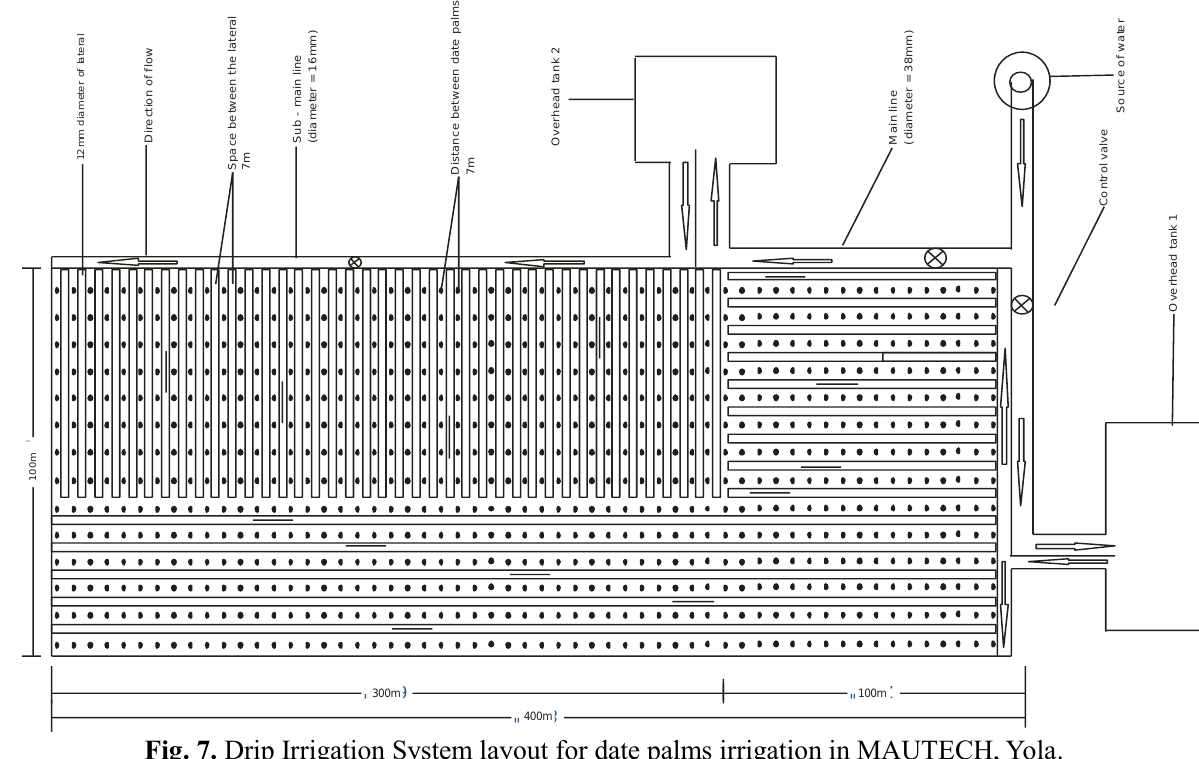
Fig. 7. Drip Irrigation System layout for date palms irrigation in MAUTECH, Yola.